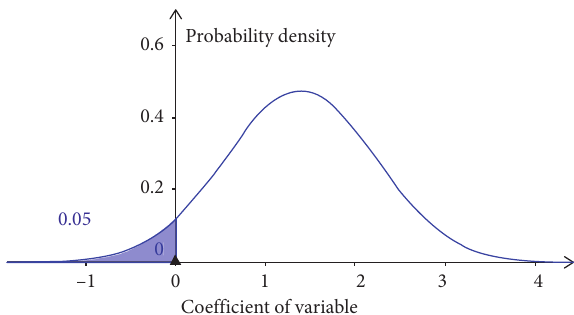
Figure 2: Varying effects of ticket purchasing method on pas- sengers’ airplane choice.